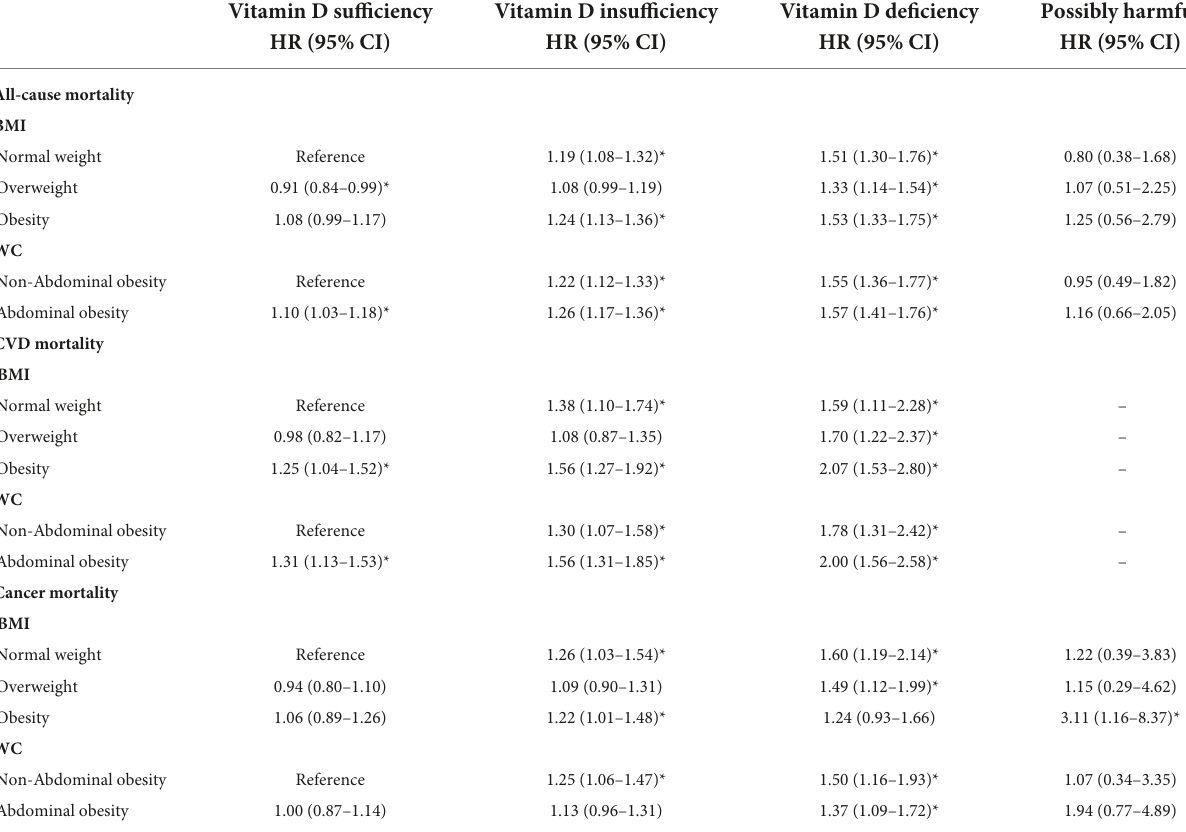
TABLE 4 The interaction effect of serum vitamin D status and obesity levels on all-cause and cause-specific mortality in NHANES III and NHANES 2001–2014: HRs (95% CIs) across different vitamin D status and obesity sub-categories. Vitamin D sufficiency Vitamin D